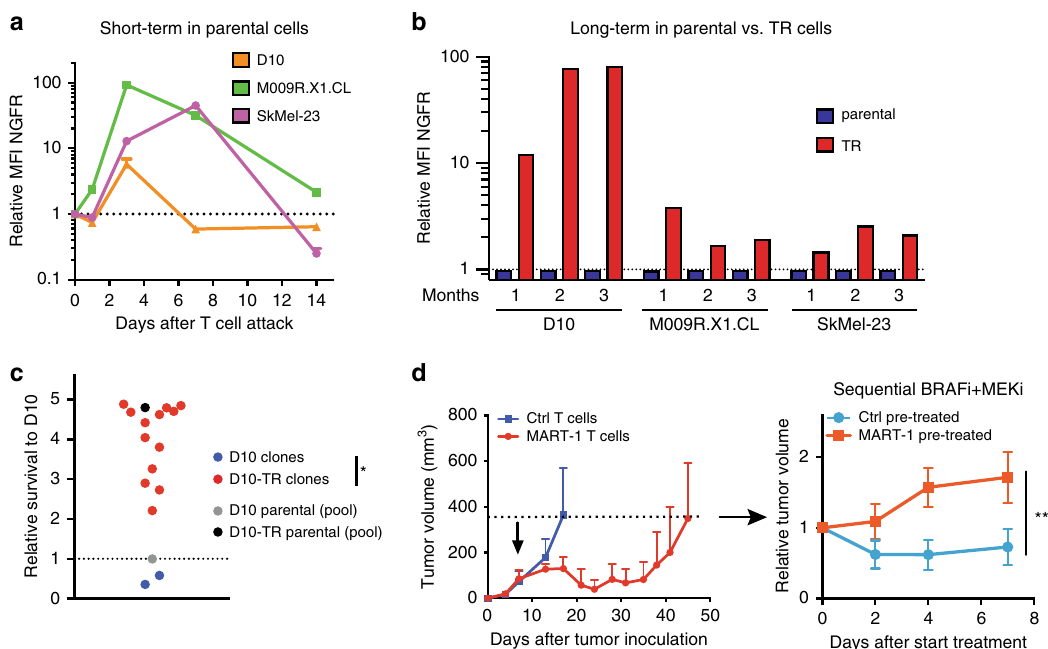
Fig. 3 Pre-existing NGFR hi cells display a stable phenotype. a Relative MFI as assessed by fl ow cytometry for parental cell lines after a 24 h co-culture with MART-1 T cells in a 1:8 ratio. After 24 h, T cells were washed off and the medium was refreshed every 3 days. Data shown from three independent replicates. b Relative MFI as assessed by fl ow cytometry of TR cell lines compared with their parental counterparts over a period of 3 months without any T cell stimulation. c D10 and D10-TR clones were obtained by FACS-based single cell sorting and expansion, and after 2 months they were subjected to MART-1 T cells in a 1:1 ratio. The relative survival compared with parental D10 cells is shown, based on quanti fi cation of the corresponding colony formation assays (from two independent replicates). Statistical analysis by Mann – Whitney test by comparing all TR clones to all parental clones; * p < 0.05. d D10 tumors were treated at day 7 with Ctrl or MART-1 T cells in vivo, and at an average tumor volume of 400 mm 3 individual mice were re-strati fi ed to sequential BRAF + MEKi treatment ( n = 6 per group; dabrafenib 30 mg/kg, trametinib 0.1 mg/kg). Error bars represent S.D. Statistical analysis by Mann – Whitney test on day 7; ** p < 0.01. Source data are provided as a Source Data fi